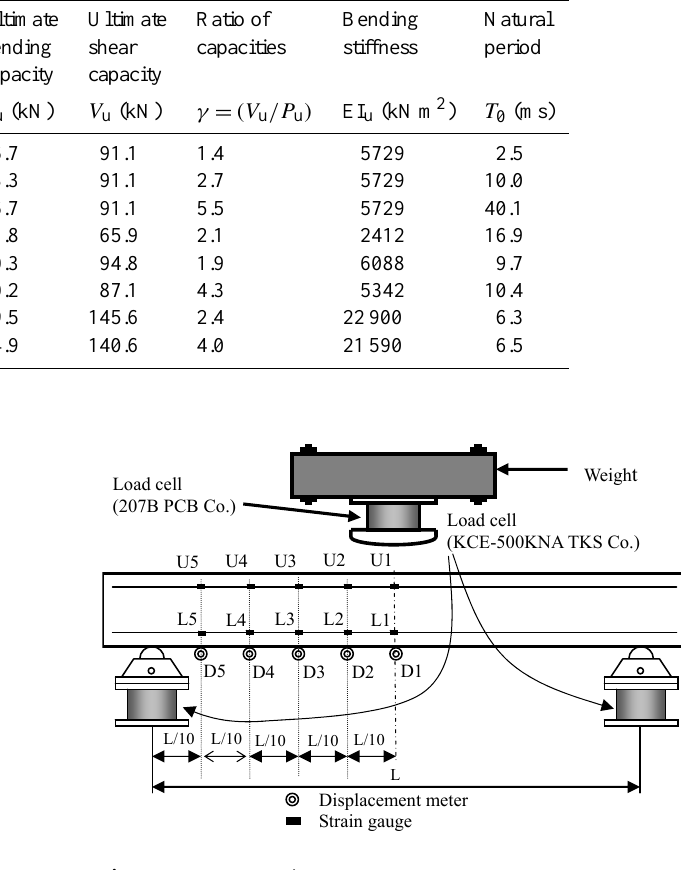
Fig. 4. Measurement items